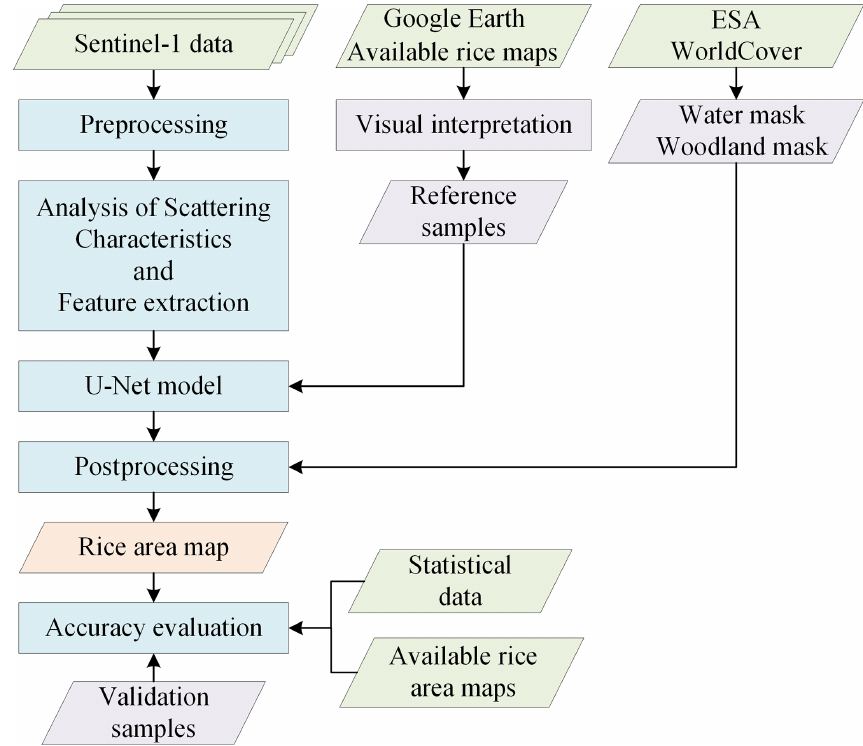
Figure 2. Flowchart of the proposed rice area mapping method using Sentinel-1 data.